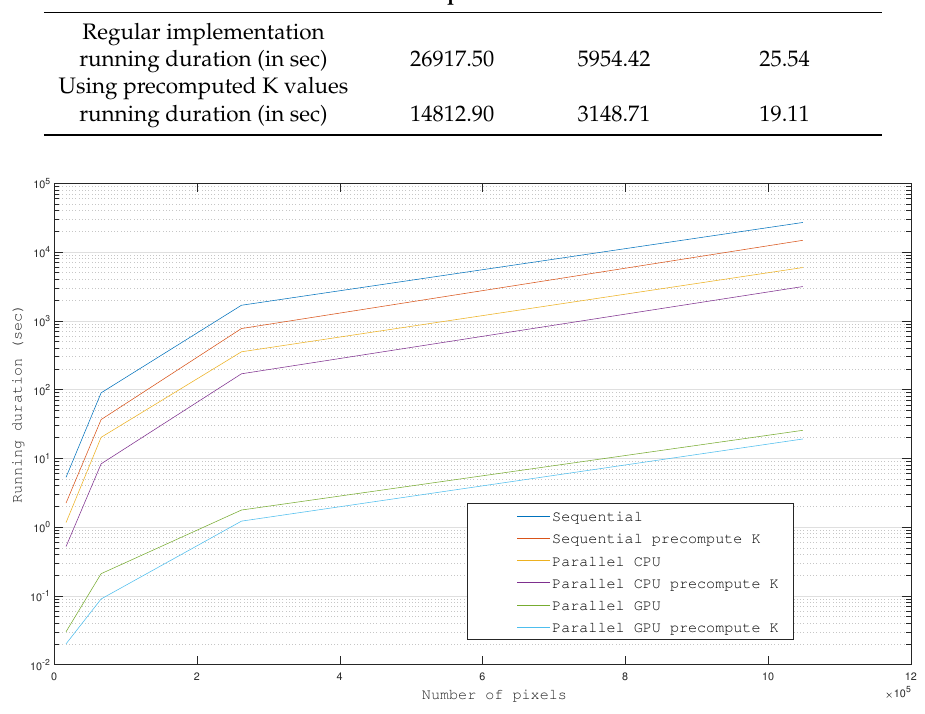
Figure 3. Running durations for all